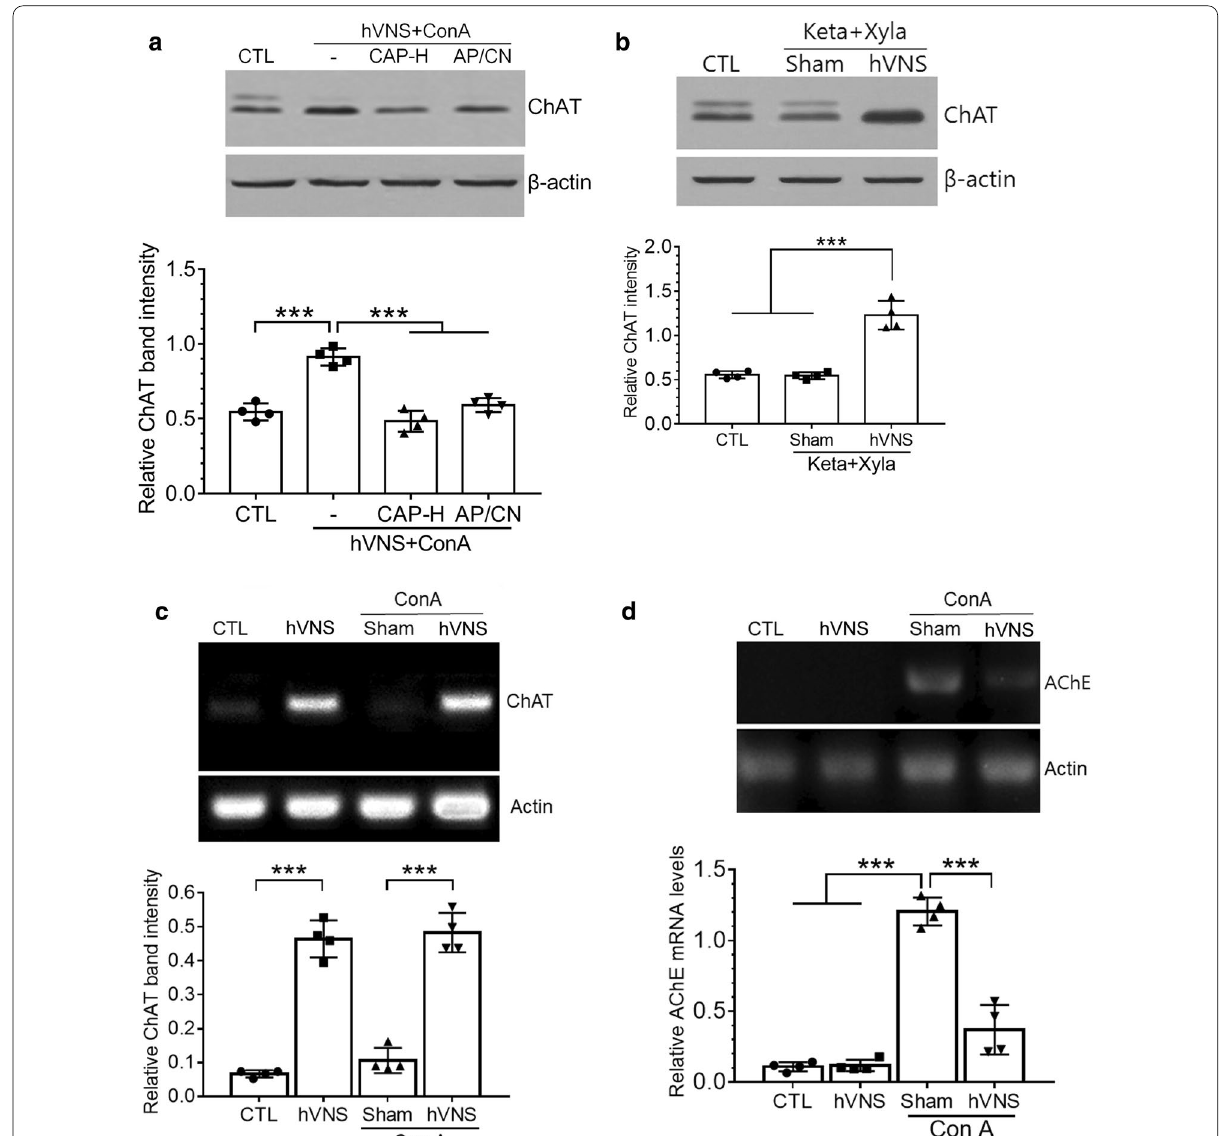
Fig. 7 Downregulation of ChAT production by CAP. a , b Western blotting of ChAT for the lysates from DVC areas prepared from individual groups as indicated in the figure. AP/CN; a group injected with AP‑5/CNQX into the DMV. Keta/Xyla; ketamine and xylazine. Western blot images in a and b are the representatives from 4 independent experiments. c , d RT‑PCR for ChAT and AChE mRNAs. Amplified DNAs were analyzed by DNA gel electrophoresis and identified in all groups as a single band at 529 bp for ChAT and 307 bp for AChE. RT‑PCR for actin as loading control. In a – d , one way ANOVA with Tukey post hoc is shown. ***p < 0.001 (n =